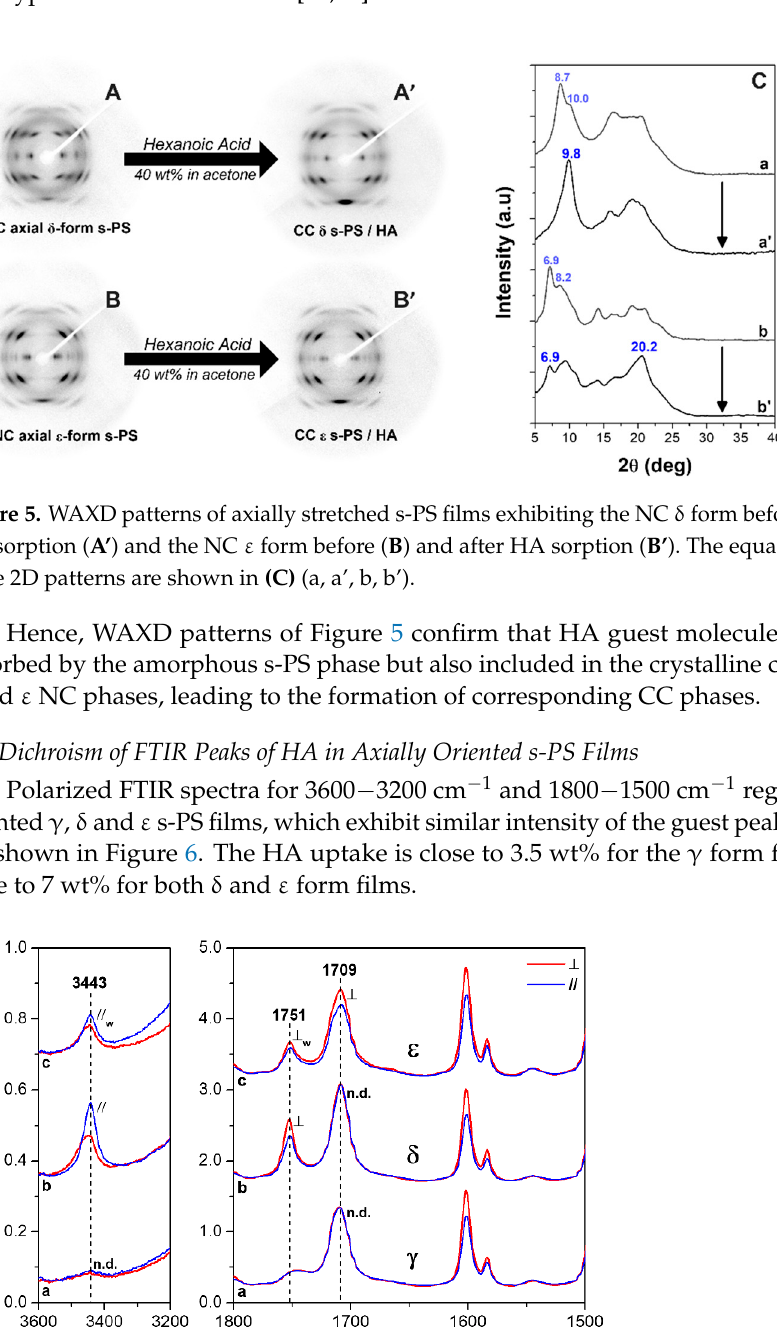
as is typical of CC ε form films [19,23].